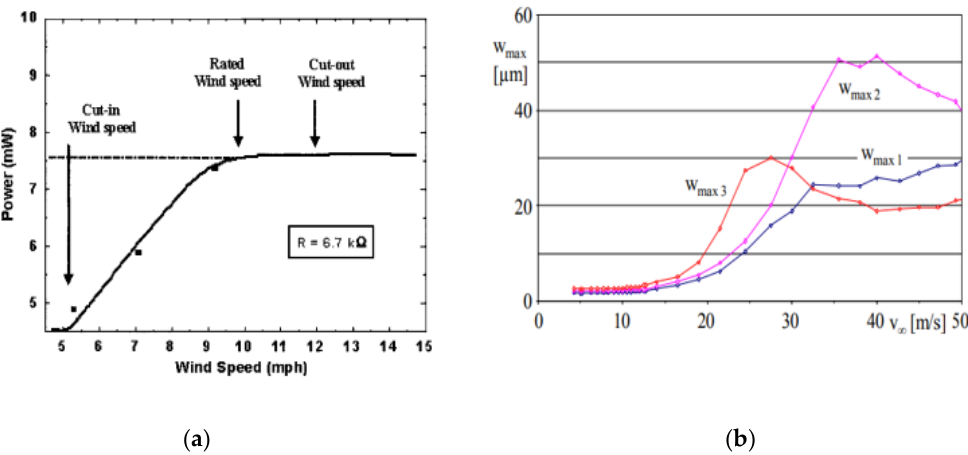
Figure 4. ( a ) Wind speed for the piezoelectric windmill with the variation in power; ( b ) at a wind speed of 40 m/s, measured voltage and power vs. external load using Series 1 and 2 cantilevers, with index “ short ” indicating L/D = 2.125 and “ long ” showing L/D = 5.057. [83].